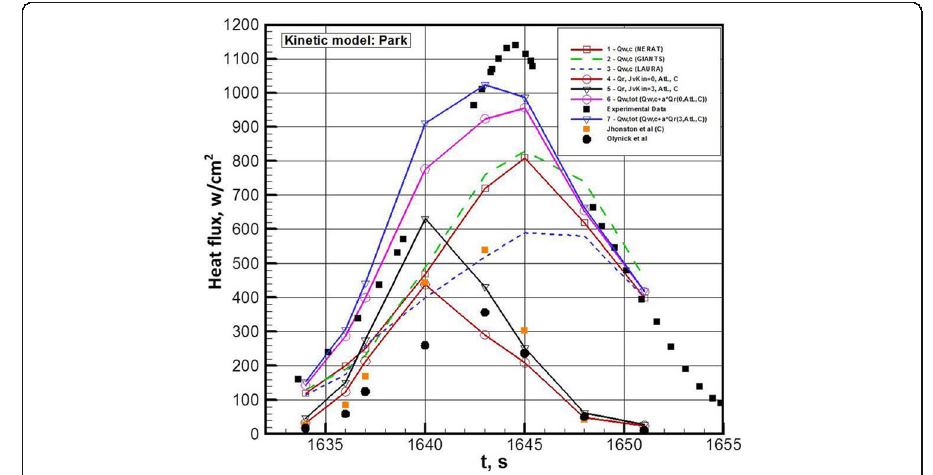
Fig. 15 Verification of numerical simulation with FIRE-II flight